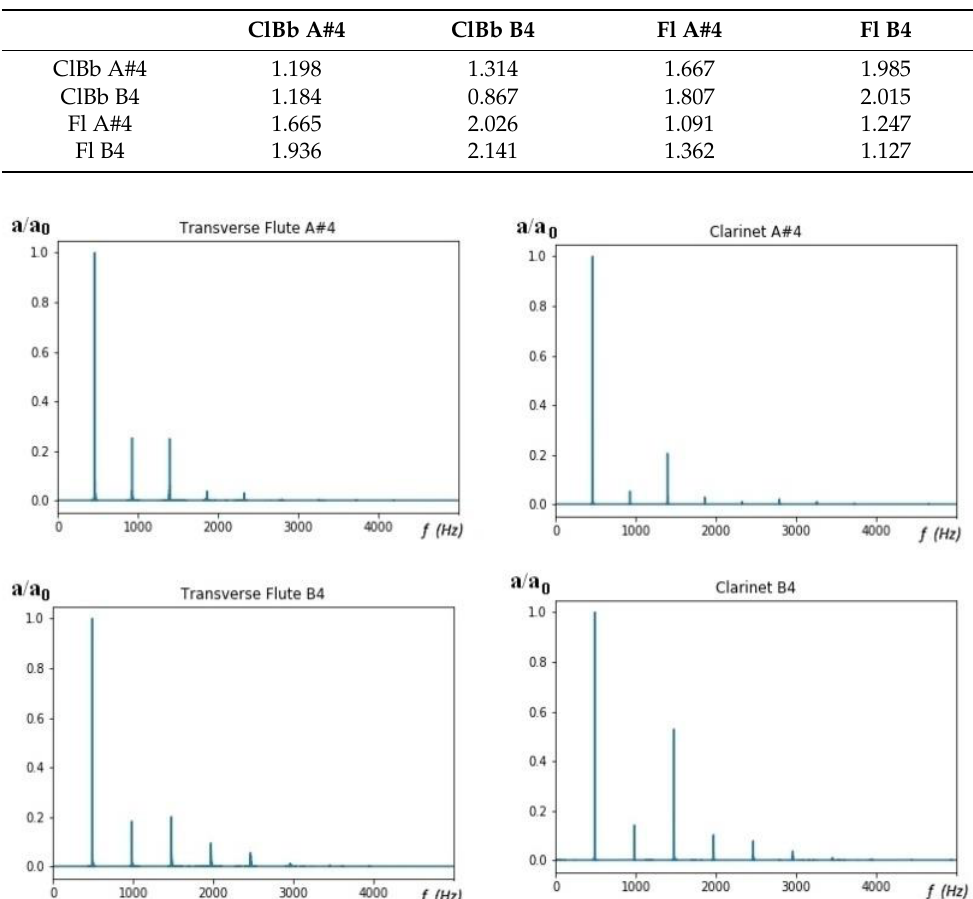
Table 1. Average distance in the timbral space of the sounds A#4 and B4 for Flute and Clarinet.